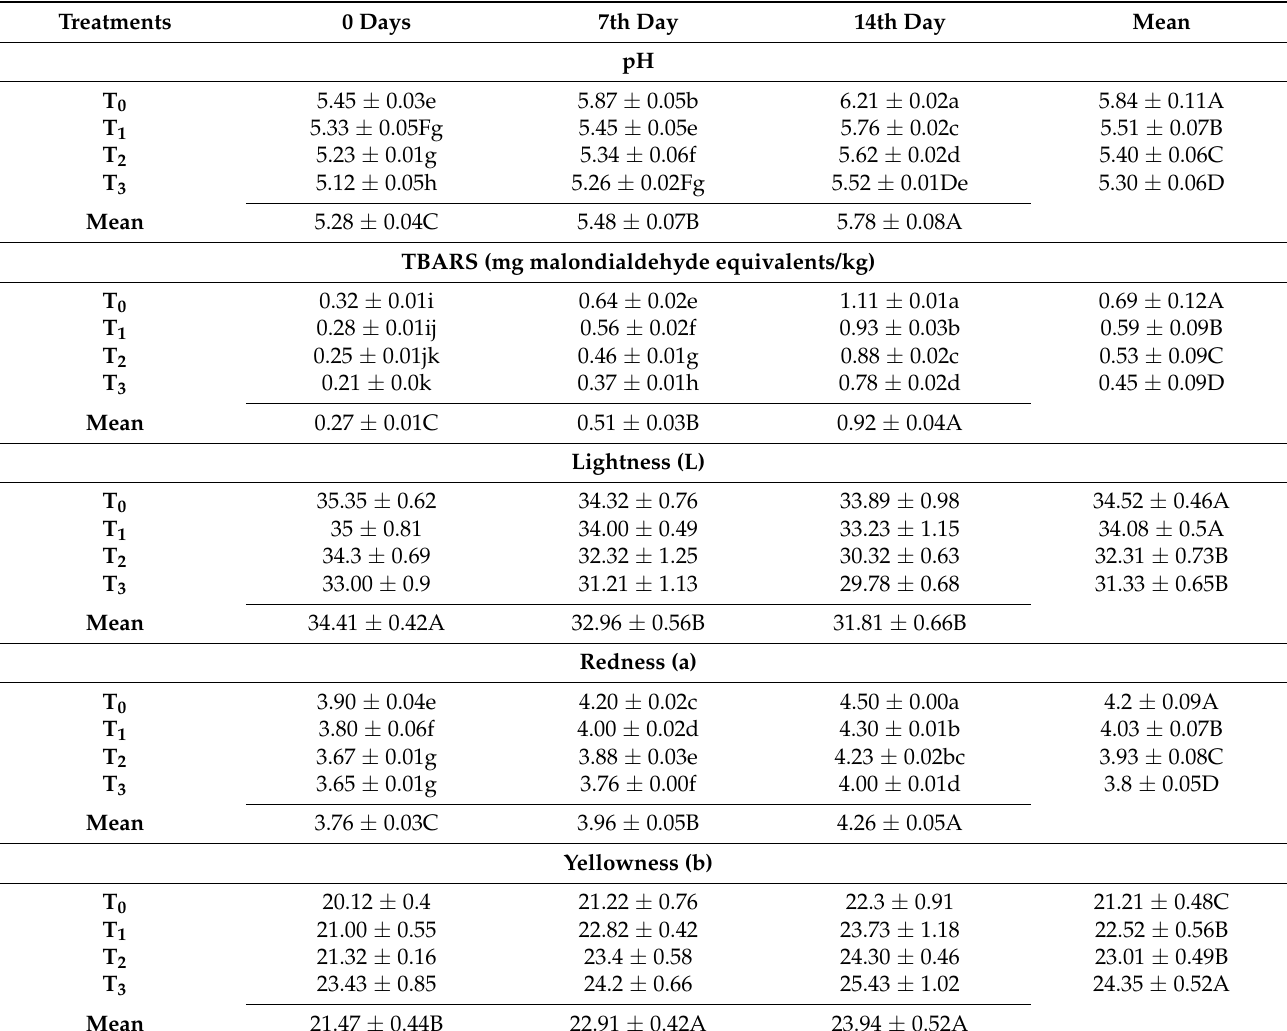
Table 7. Effect of O. basilicum essential oil supplementation on pH, TBARS, L, a and b value of chicken nuggets after refrigerated (4 ◦ C)